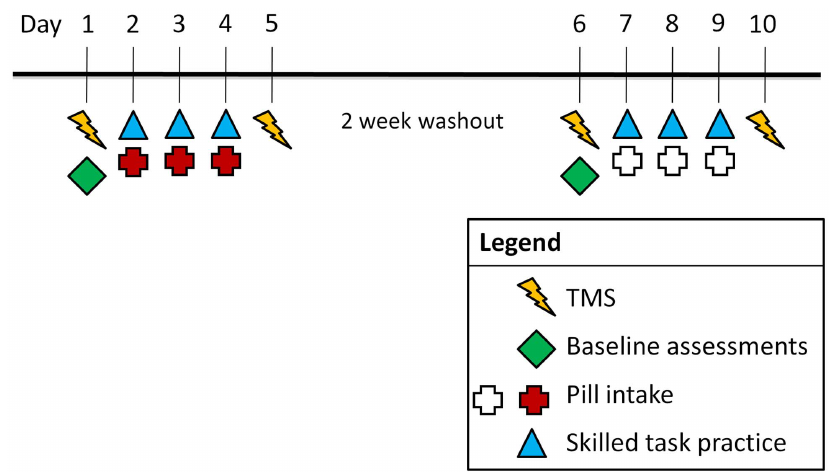
Figure 1. The experimental protocol.